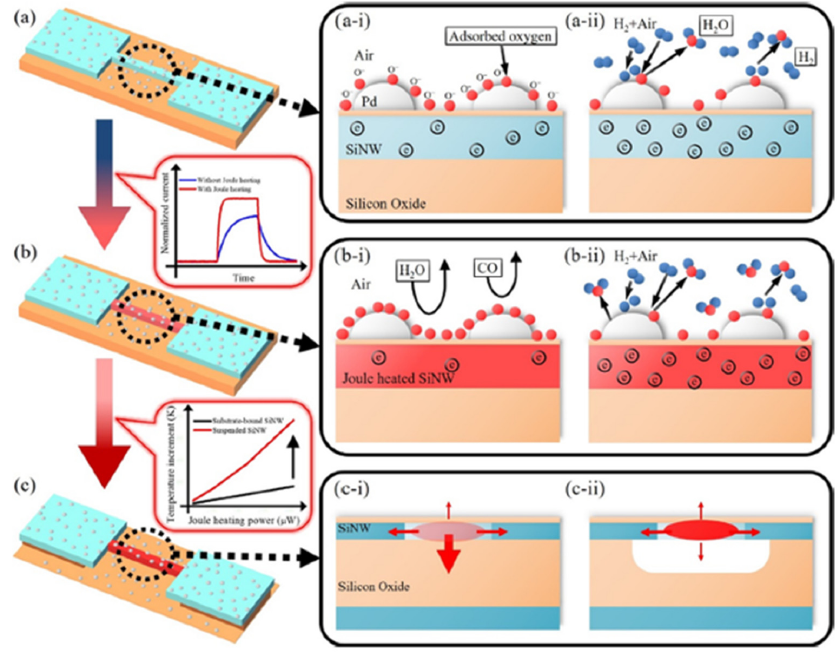
Figure 12. Working principle of H 2 sensing of a Pd-SiNW. ( a ) At room temperature, ( a – i ) depletion of charge carrier (electron) in SiNW (n-type) by negatively charged adsorbed oxygen ions (red dots) and ( a – ii ) accumulation of charge carrier by desorbing oxygen with H 2 O formation under H 2 gas exposure. ( b ) Faster and higher response with Joule heating of Pd SiNW because ( b – i ) more adsorbed oxygen causes more depletion of charge carrier and ( b – ii ) it has a fast reaction rate with H 2 , but a low interfering gas effect (H 2 O and CO) with Joule heating. ( c ) By replacing substrate-bound SiNW with suspended SiNW, the heat loss through the substrate is reduced, resulting in lower power consumption [69]. Copyright (2017), with permission from American Chemical Society.